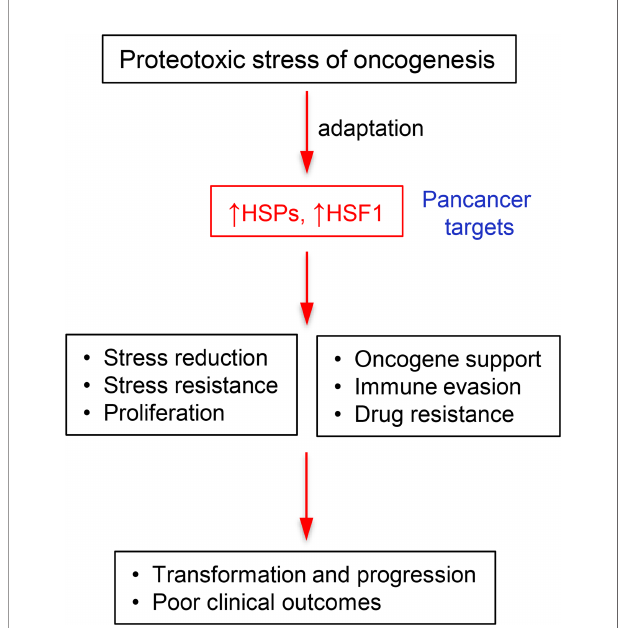
FIGURE 5 | Flow chart depicting the role of heat shock proteins and HSF1 in